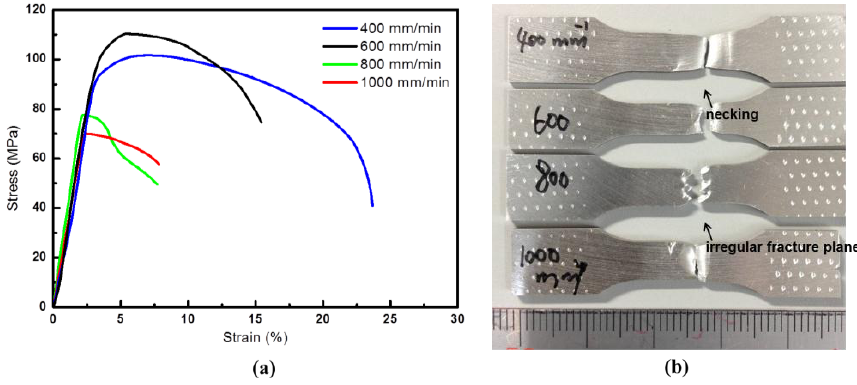
Figure 10. ( a ) Tensile strain-stress curves of the dissimilar FSW joints produced at different welding speeds; and ( b ) photo of the fractured specimens after the tensile tests.